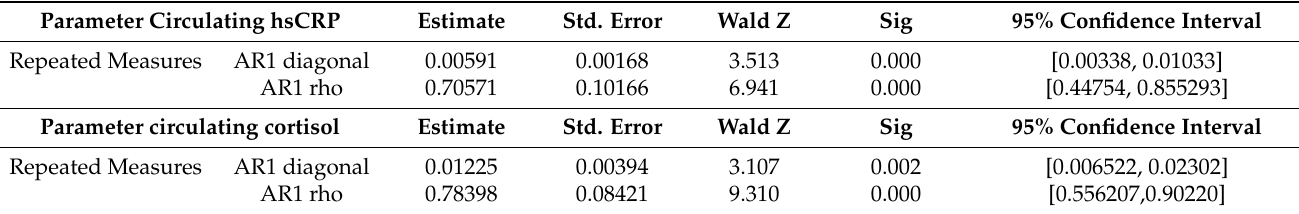
Table 4. Differences in slopes of the first time point sampling with the three following points (co- variance parameter baseline circulating (blood) hsCRP/cortisol) (n = 20).